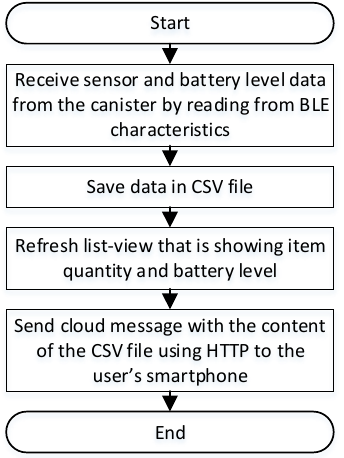
Figure 4. Flowchart of actions when BLE data are received.